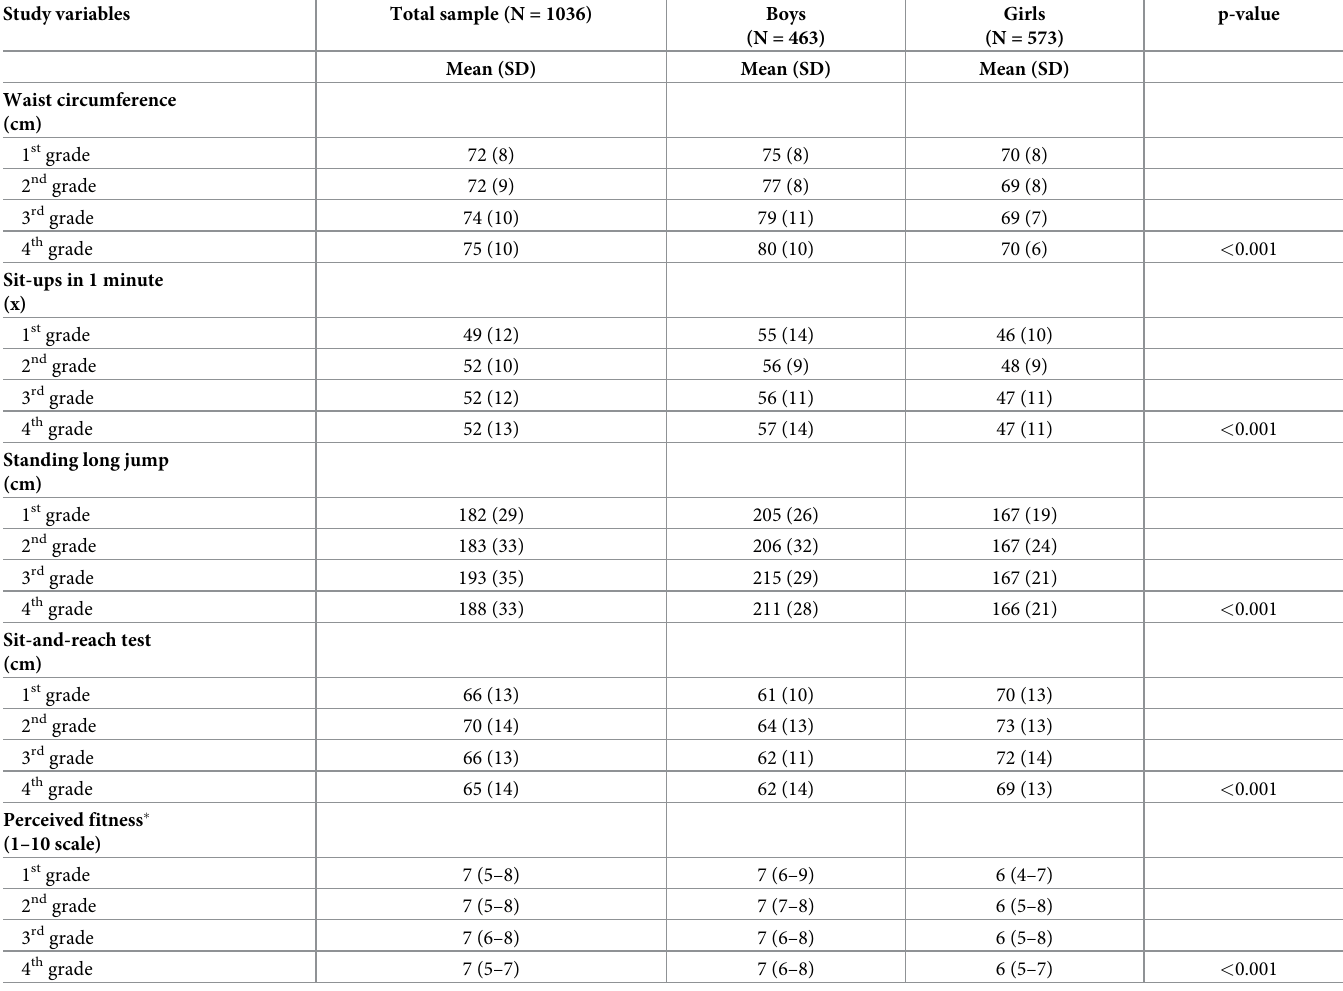
Table 1. Basic descriptive statistics of the study participants, stratified by sex and age (Croatia,